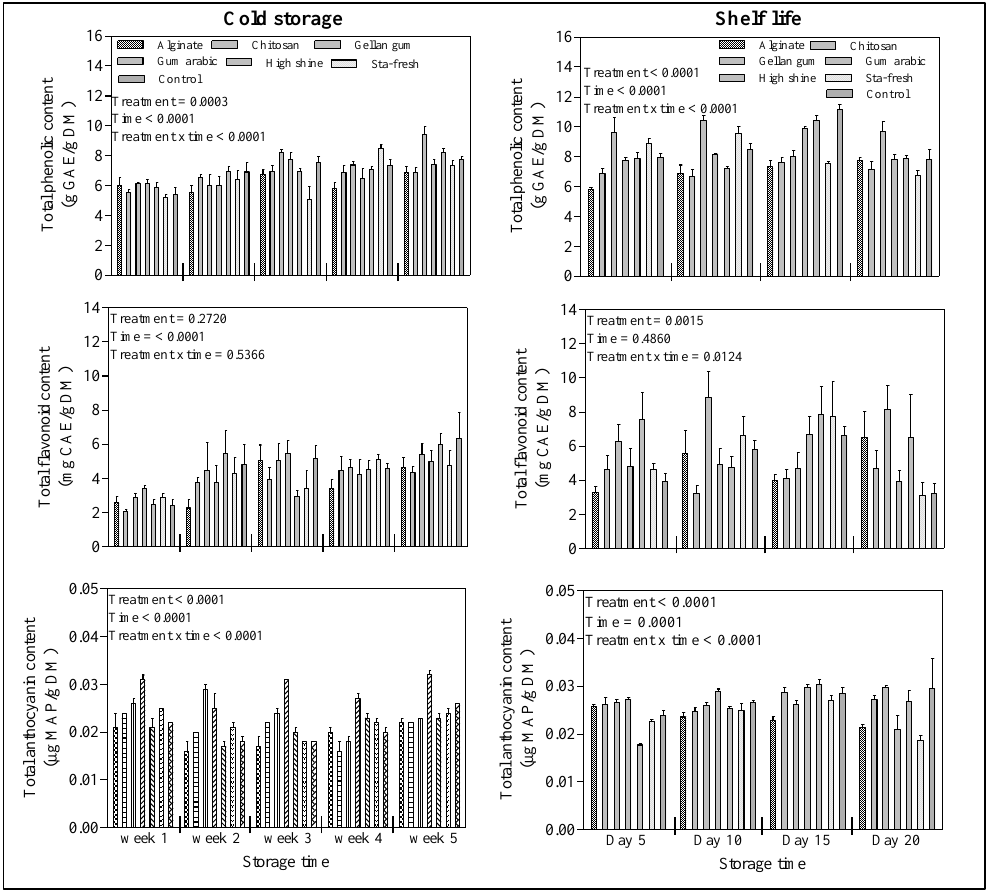
Figure 4. Total phenolic content (g GAE/g), total flavonoid content (mg CAE/g) and total anthocyanin content (μg MAP/g) in plums (‘African Delight™’) during a simulated shipping period (cold storage; −0.5 ± 2 °C and 90 ± 5% RH for 5 weeks) and shelf life (20 ± 2 °C and 75 ± 5% RH for 20 d). Means ± standard errors presented. In other to determine the interaction effects, factorial ANOVA was performed for main factors; treatment and storage time separately for cold storage and shelf life periods for each attribute.